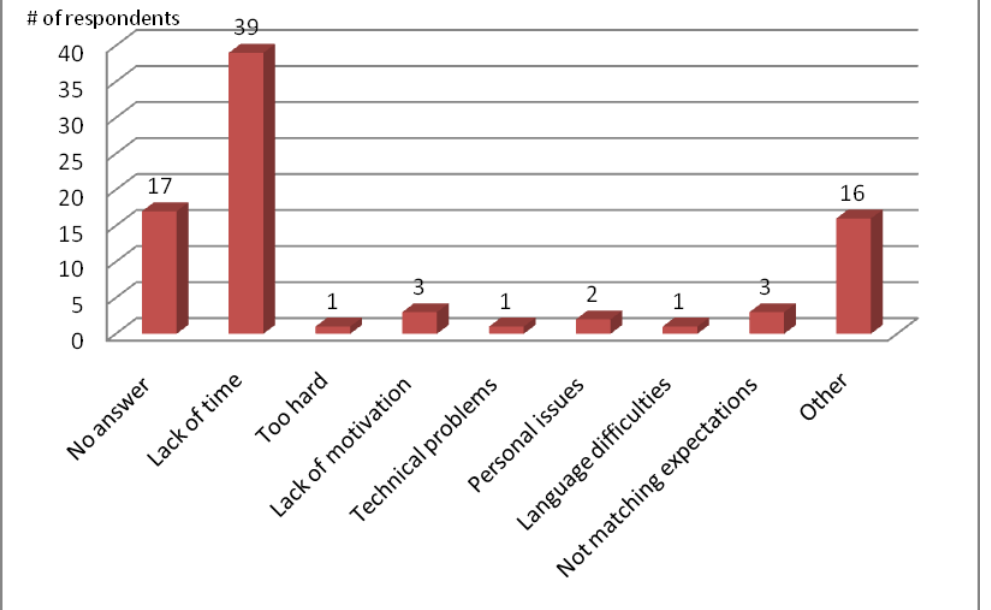
Figure 5 . Reasons for not having completed the course ( N =